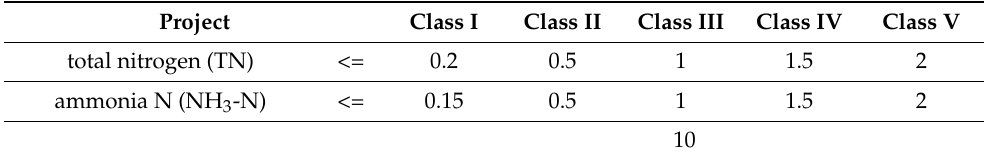
Table 1. The nitrogen projects in the Chinese guidelines for the environmental quality standard for surface water (GB 3838-2002).